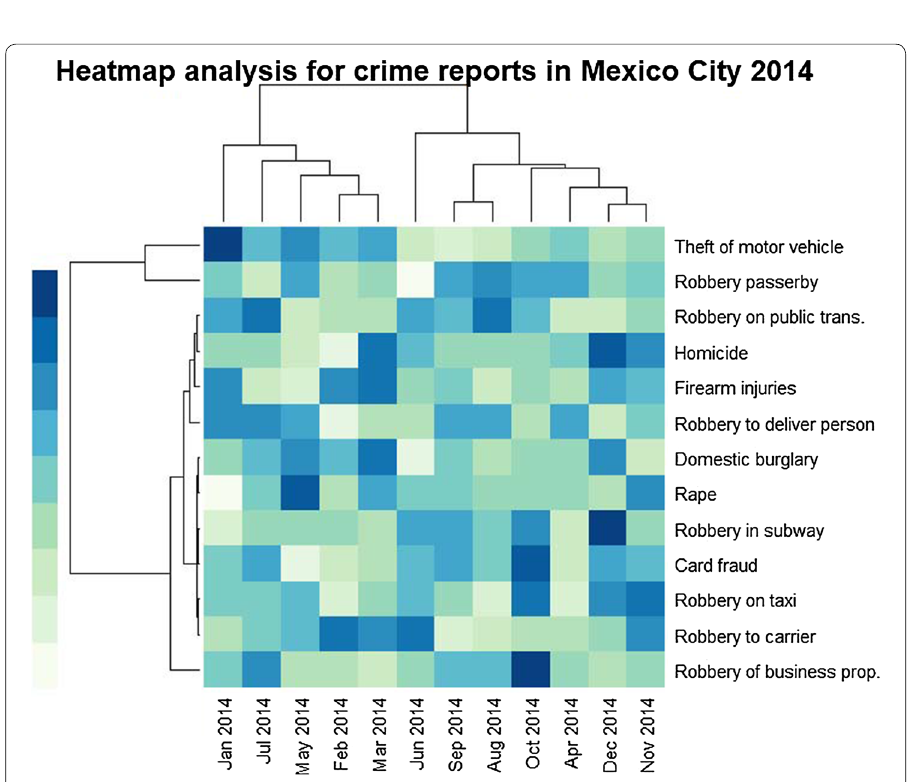
Fig. 7 Heat map analysis of crime reports in Mexico City: